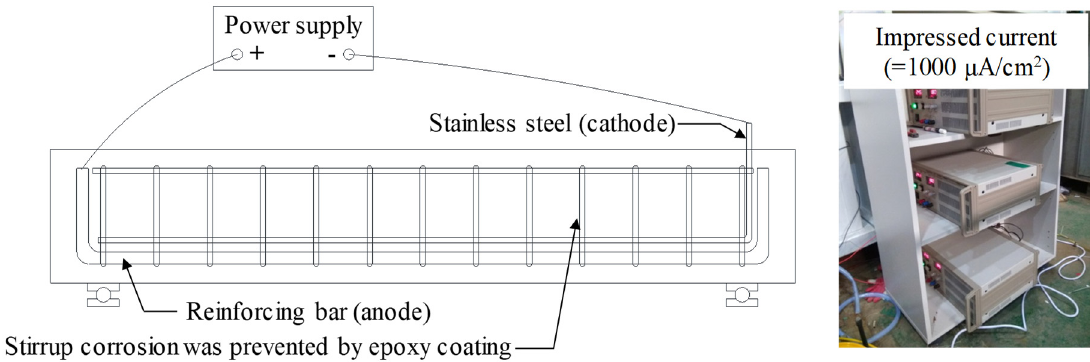
Figure 2. Schematic description of accelerated corrosion test.